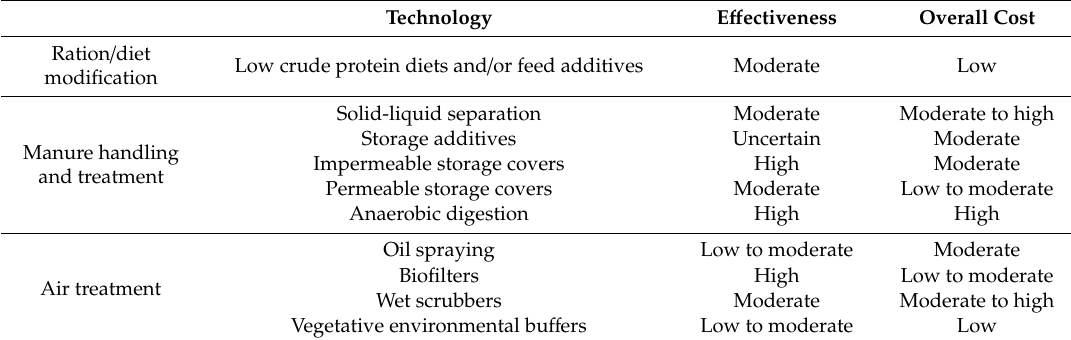
Table 2. Summary of odor control technologies in swine facilities